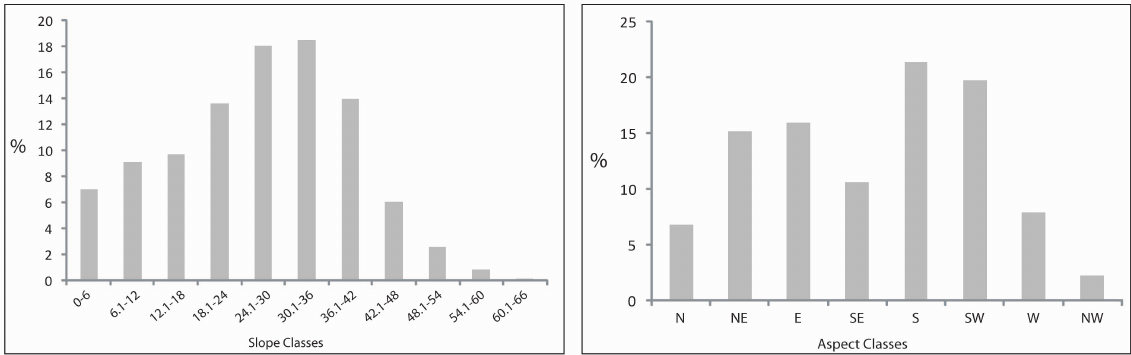
Fig. 8. (a) Histogram of slope classes (intervals of 6 ◦ ) for the slopes affected by the landslides of the 1 October 2009. (b) Histogram of aspect